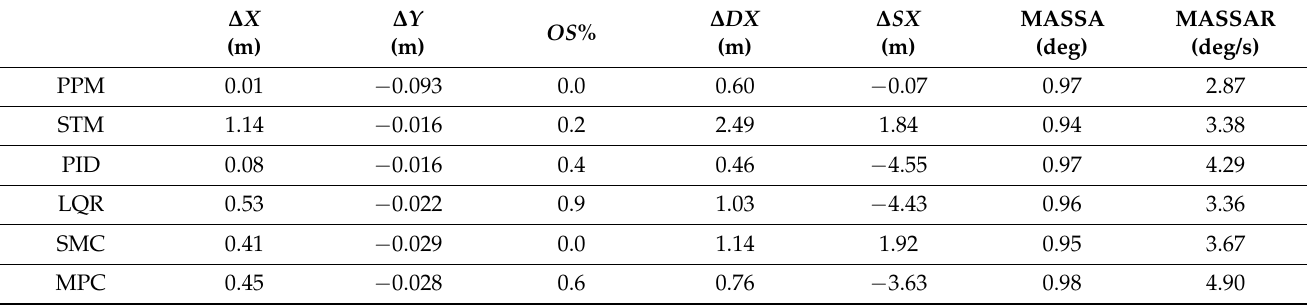
Table 3. Summary of simulation results of each controller for 4WS vehicle in the first set of simula- tions.